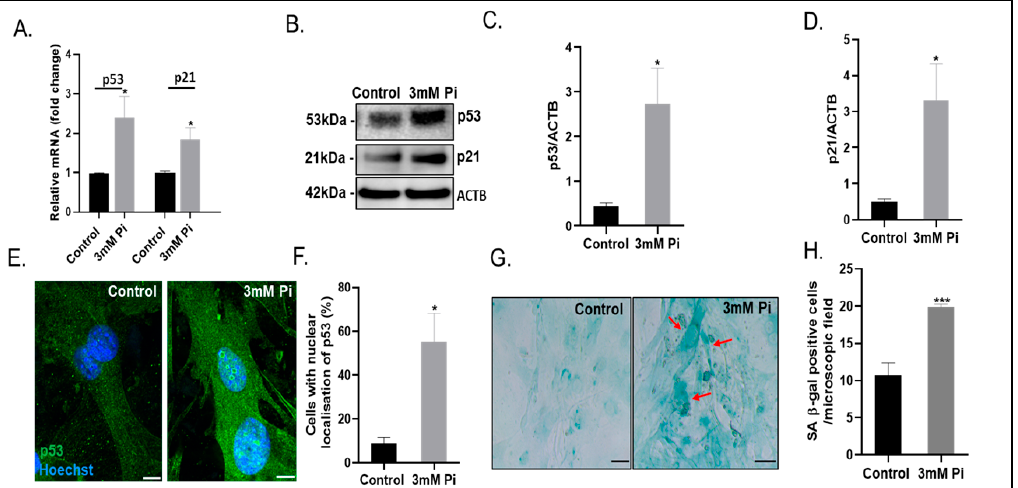
Figure 4. Increased senescence in calcified VSMCs ( A ) Fold change in mRNA expression of p53 and p21. ( B ) Representative immunoblots and associated quantification of ( C ) p53 and ( D ) p21 compared with ACTB ( β -actin). ( E ) Representative images and ( F ) associated quantification of cells with p53 staining in the nucleus ( G ) Representative images and ( H ) associated quantification of SA β -gal staining (red arrows indicate positive staining). Data shown as mean +/ − S.E.M (n = 3–6) * p < 0.05; *** p < 0.001 compared to control. Scale bars = 5 µm.